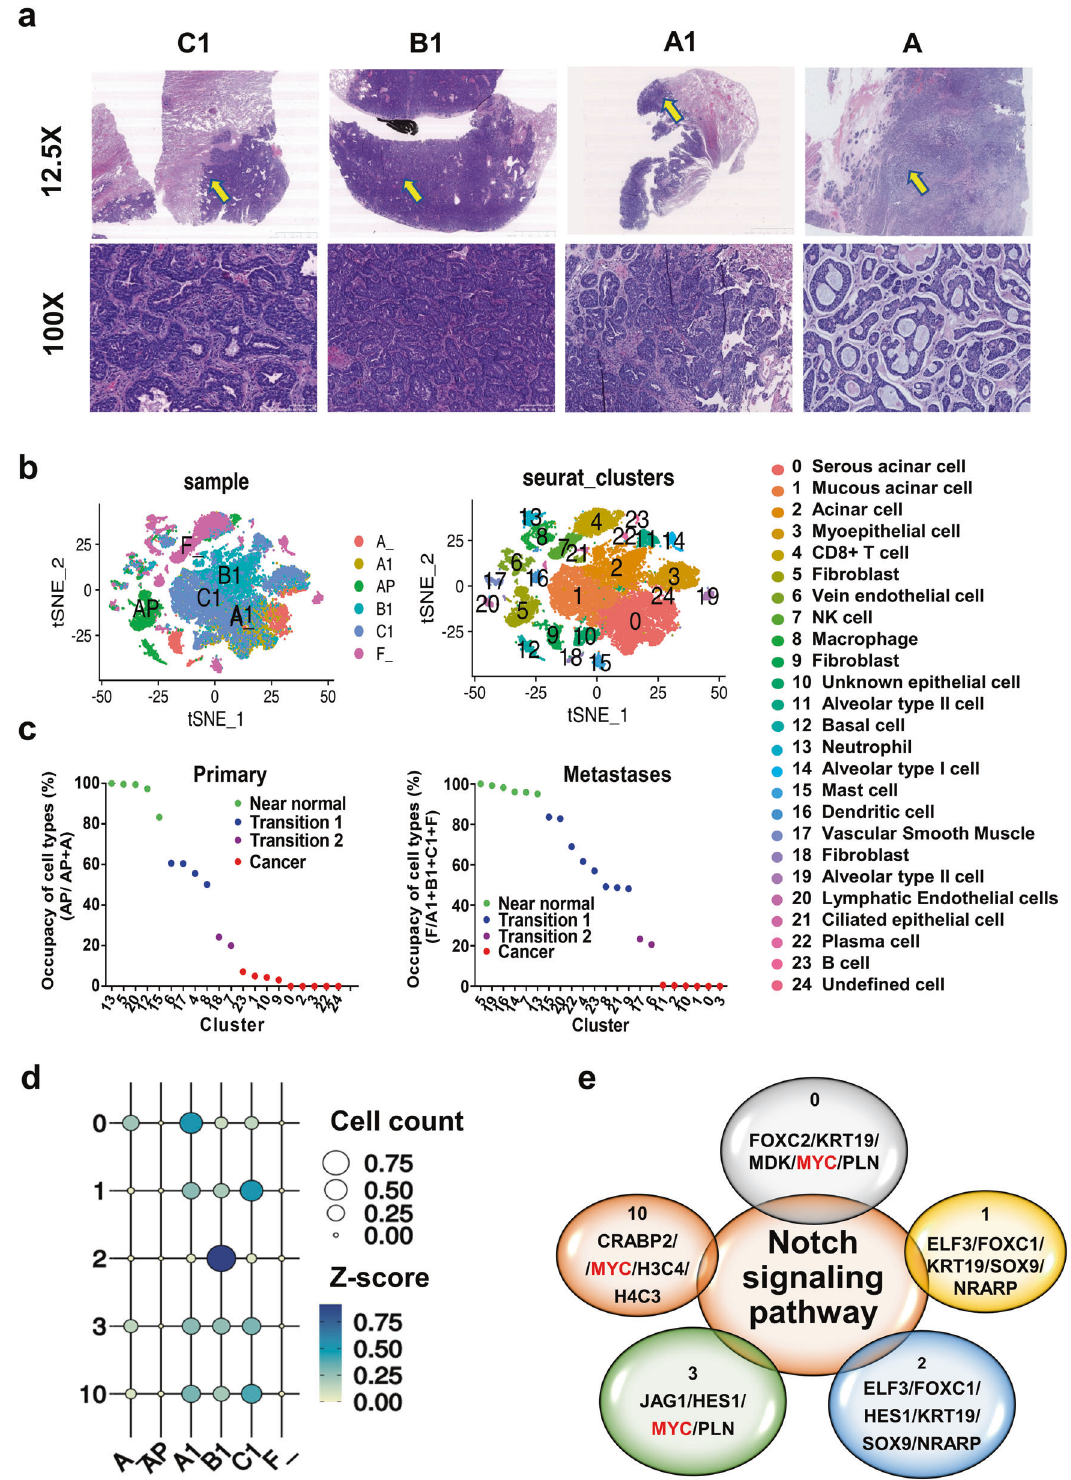
Fig. 1 Cancer cell type de fi nition and GO enrichment analysis based on scRNA-seq data. a Images of HE staining show a primary SACC lesion (A) and lung metastases in the right middle lobe (B1) and the right lower lobe (A1 and C1) at 12.5× and 100× magni fi cation. b t-SNE plots of six sample types (left) and all cells (right) led to the identi fi cation of 25 cell clusters based on cellular identity, and all cell types are de fi ned by known marker genes (see Supplementary Table 2). c The statistical plots show the normal tissue occupancy for each cell type (see the formula in the Results) in the primary lesion (left) and metastases (right). These data were used to divide the cells into four stages: near- normal (>80%), transition 1 (50 – 75%), transition 2 (15 – 40%), and cancer (<14%). d The bubble plot indicates the number of cancer-stage cells (cells in clusters 0, 1, 2, 3, and 10) in the six samples. e The Venn diagram shows the predominant DEGs in the cancer-stage cell clusters (clusters 0, 1, 2, 3, and 10) and the shared enriched GO term: the Notch signaling